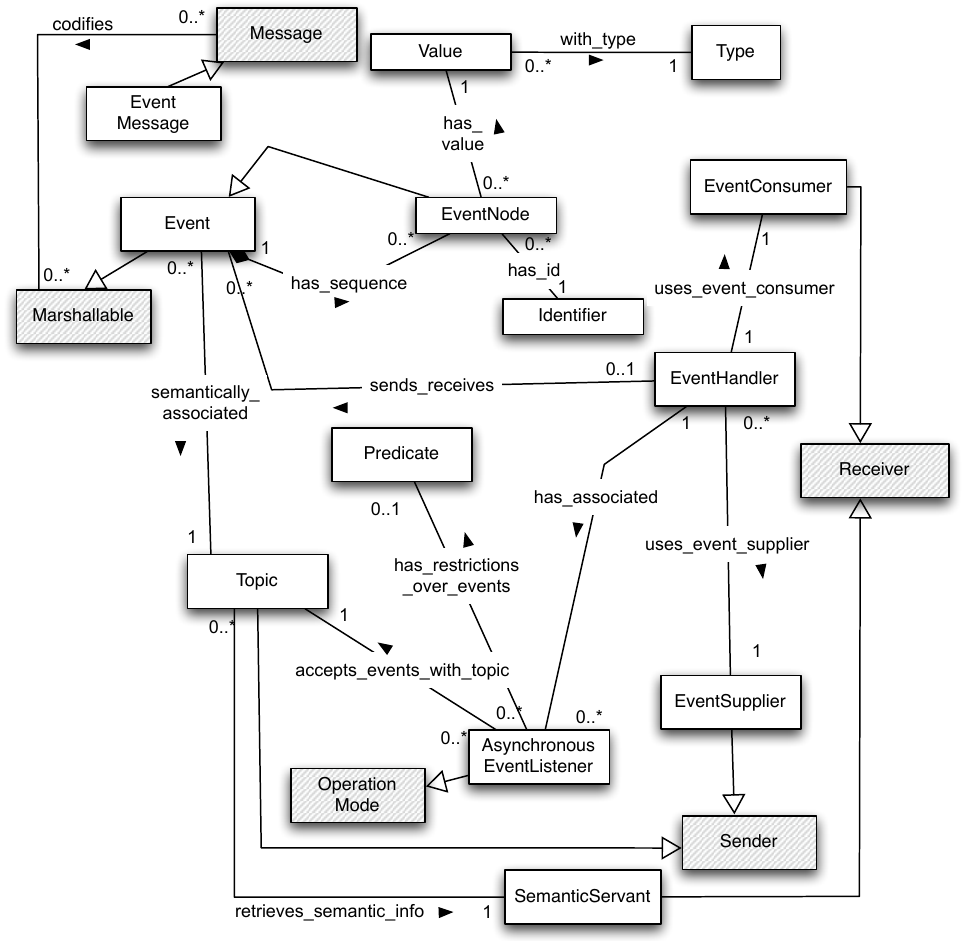
Figure 3. Specialized model to support PubSub